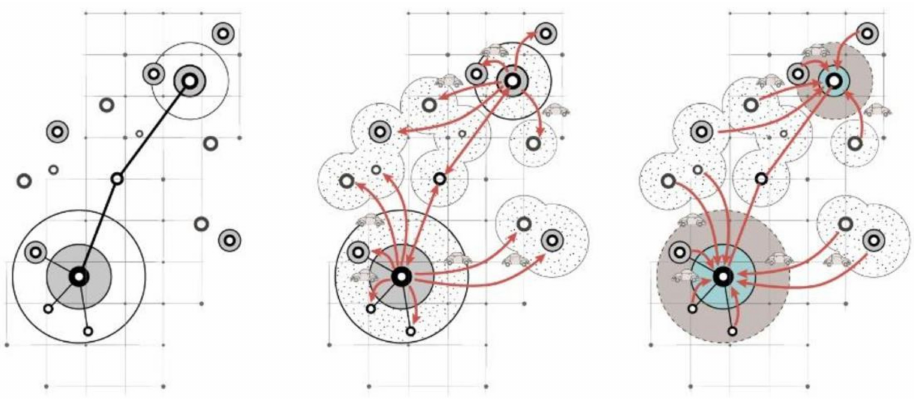
Figure 4. CAVs’ effect on building density [48].